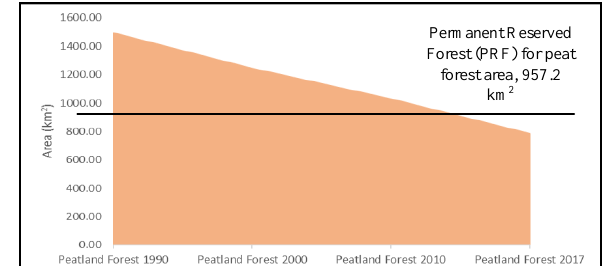
Figure 2. Spatial land use distribution in RomPek district in; (from top left) 1990, 2000, 2010, and 2017